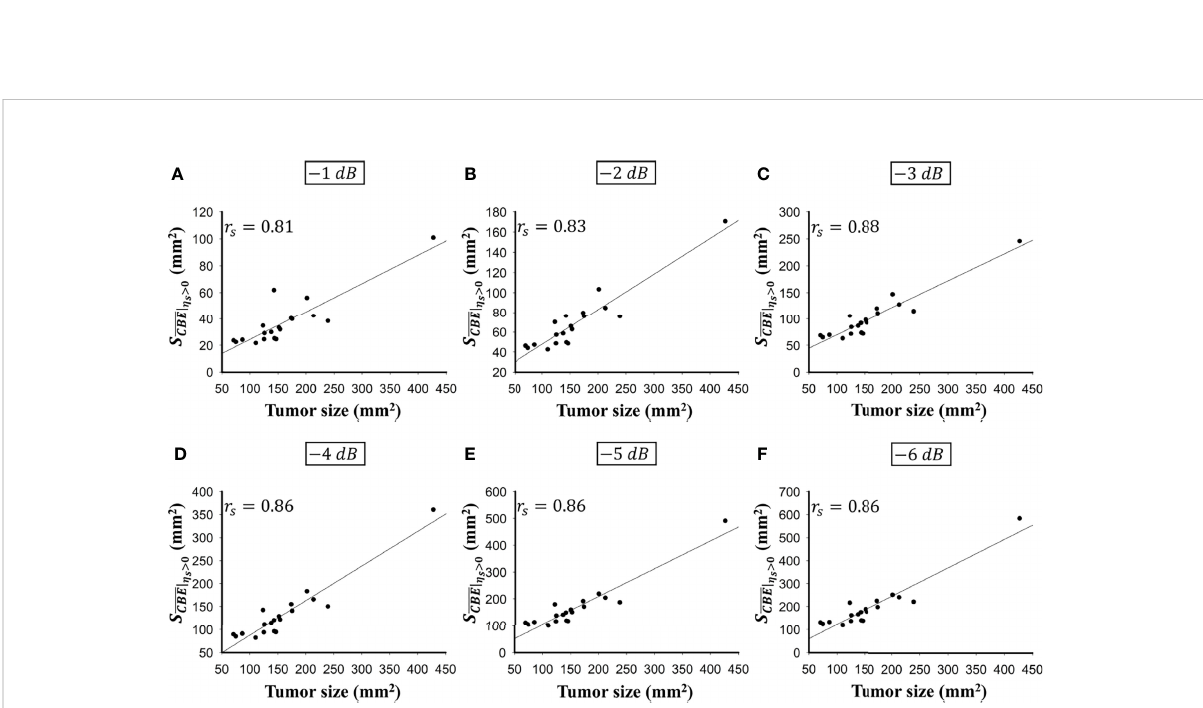
FIGURE 6 The relationship between the tumor size and S CBE j obtained according to various contour criteria. (A) − 1 dB; (B) − 2 dB; (C) − 3 dB; (D) − 4 dB; h s> 0 (E) − 5 dB; (F) − 6 dB. The values of S CBE j using various contour criteria correlated with the size of the liver tumor ( p < 0.05; r s = 0.81 to 0.86 h s> 0 corresponding to − 1 to − 6 dB